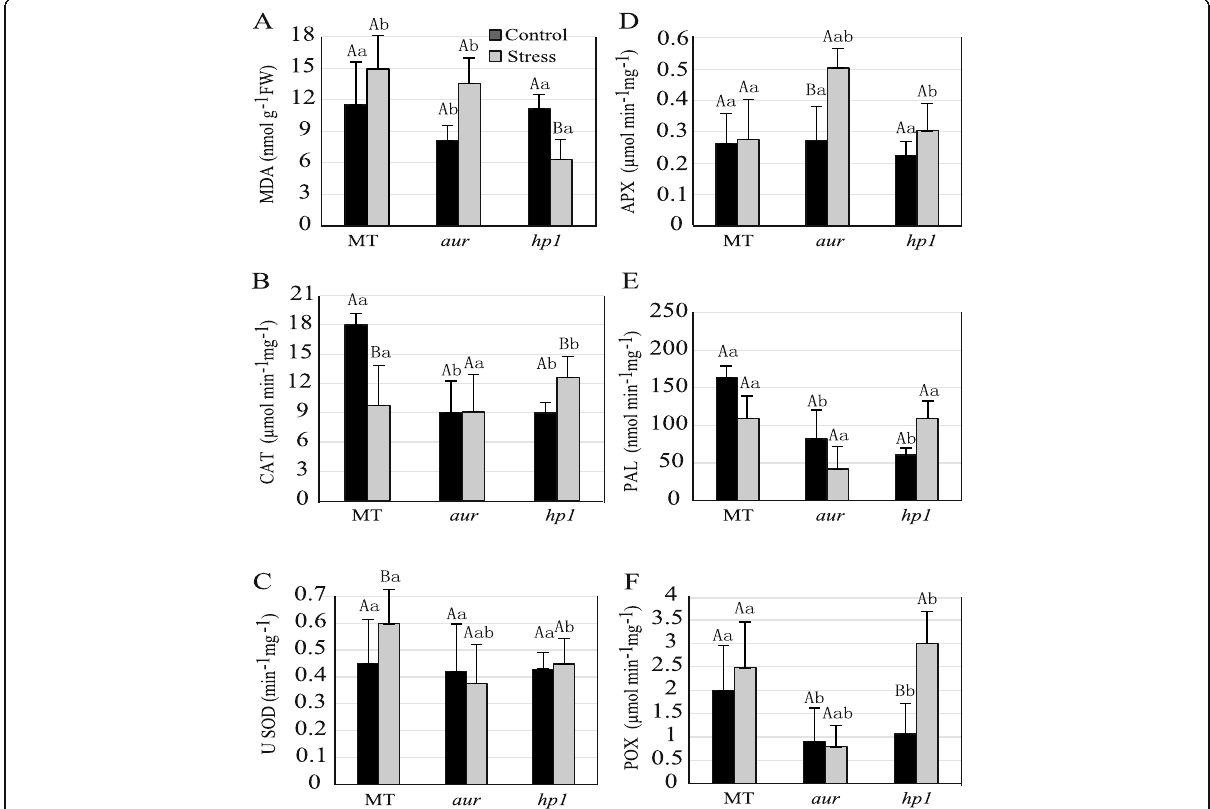
Fig. 5 Effect of chilling stress on a malondialdehyde (MDA) content and b – f activities of antioxidant enzymes in leaves of the wild-type genotype (MT) and aurea ( aur ) and high pigment1 ( hp1 ) mutants of tomato cv. Micro-Tom under control and chilling stress conditions. Symbols that are not similar show significant differences (calculated by Tukey ’ s test, P < 0.05). Comparisons between control and stress within the same genotype were denoted in upper case letters, while comparisons among genotypes under the same treatment (control or stress) were denoted in